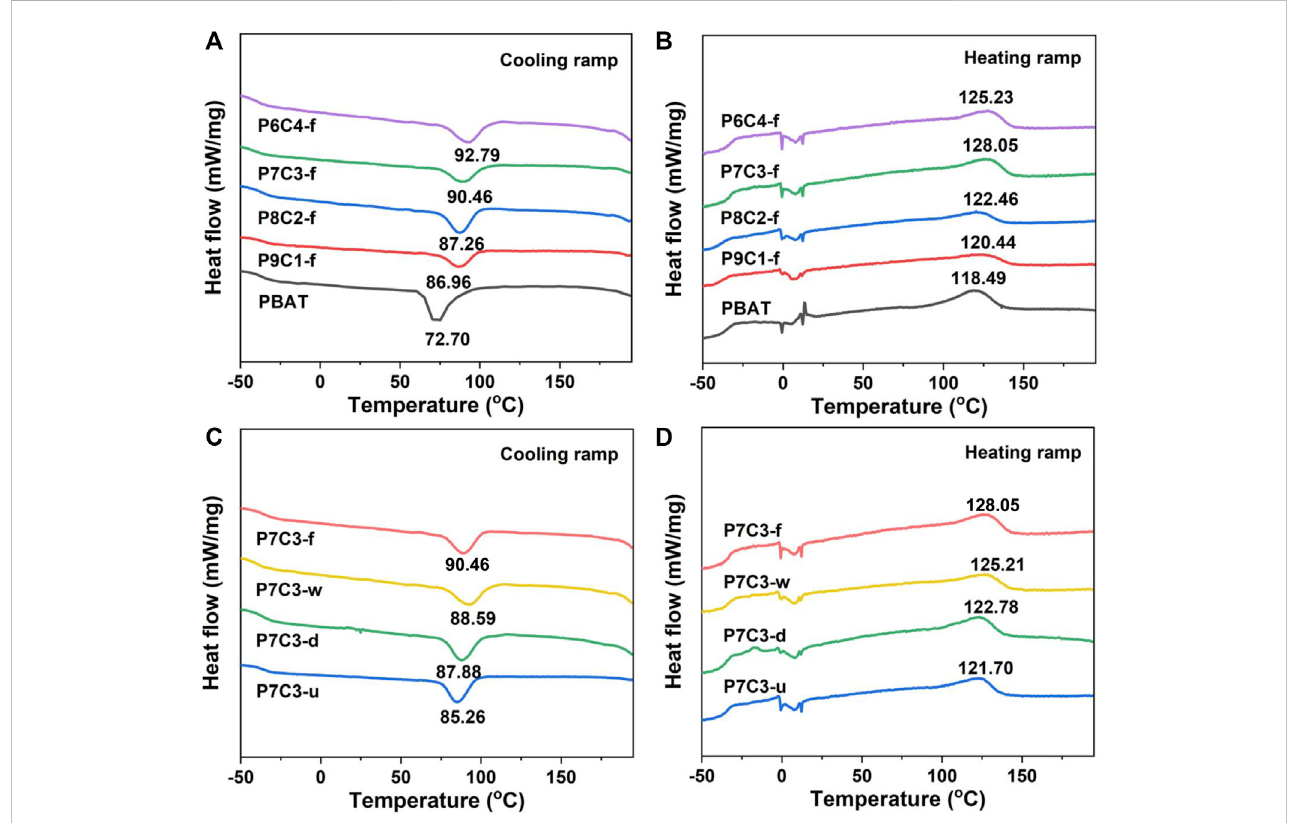
FIGURE 3 (A) Coolingand (B) heatingrampsofPBATcomposites fi lledwithdifferentamountsofgas – solid fl uidizationmodi fi edCaCO 3 . (C) Coolingand (D) heating